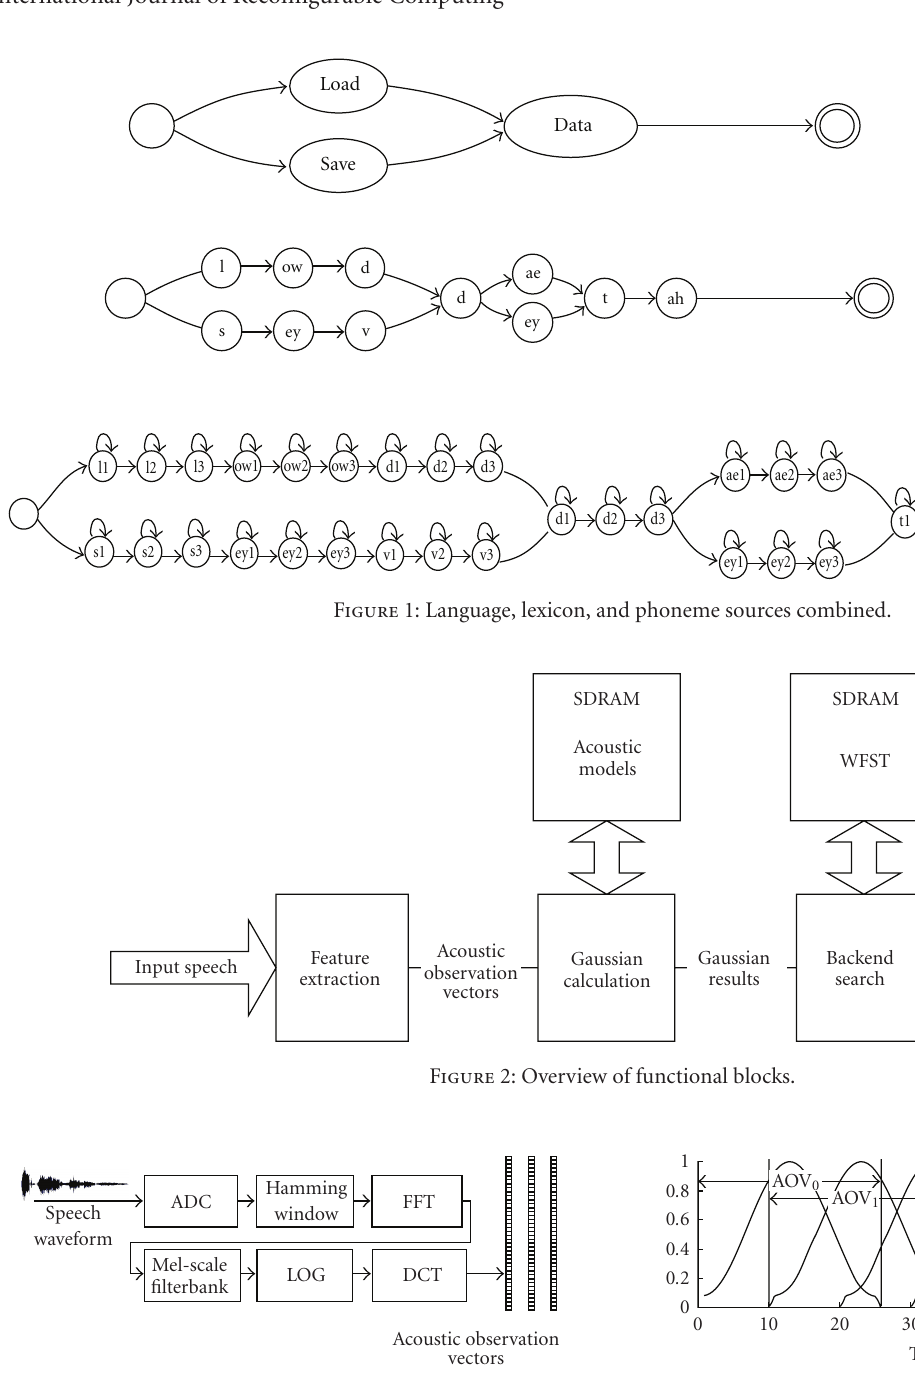
Figure 3: Translation of AOVs from input audio. Figure 4: Overlapping of acoustic observation